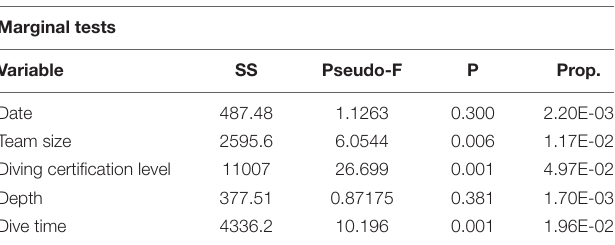
TABLE 5 | Results of distance-based linear modeling